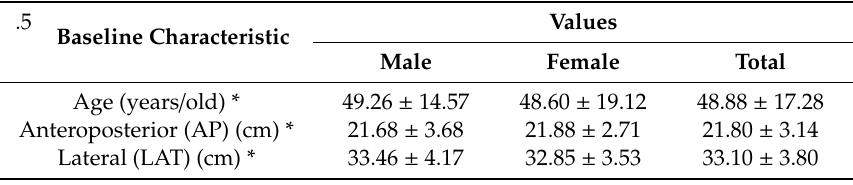
Table 1. Baseline characteristic and demography of the subjects.